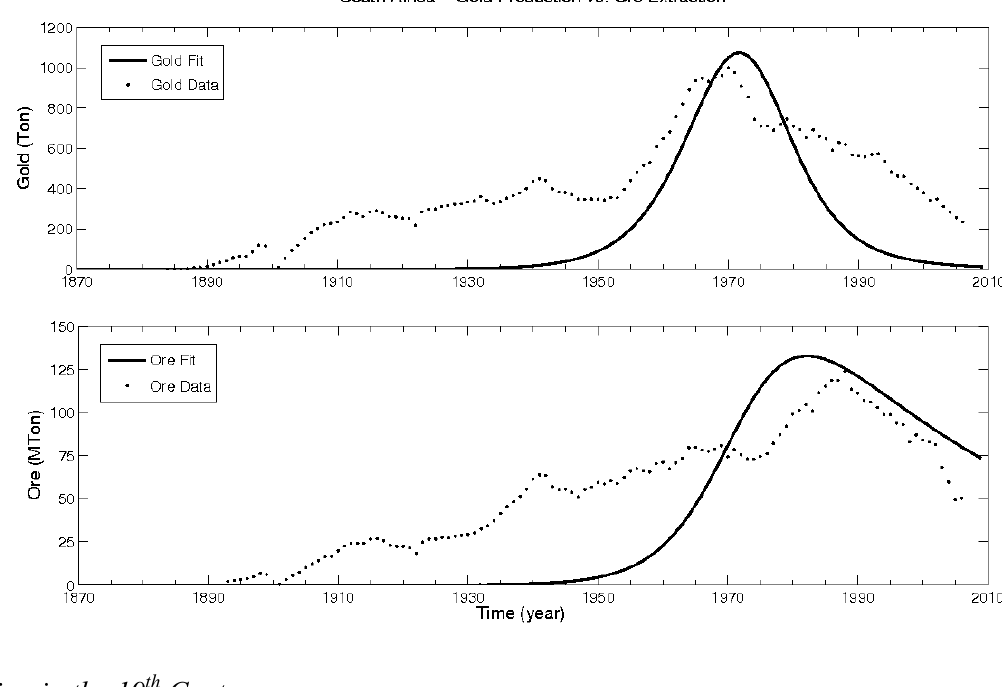
Figure 4. LV model fitting of gold production in South Africa. In this case, the resource is the gold itself, while the amount of ore mined can be assumed to be proportional to the effort (i.e., the capital) placed by the gold industry in extraction. Data are from